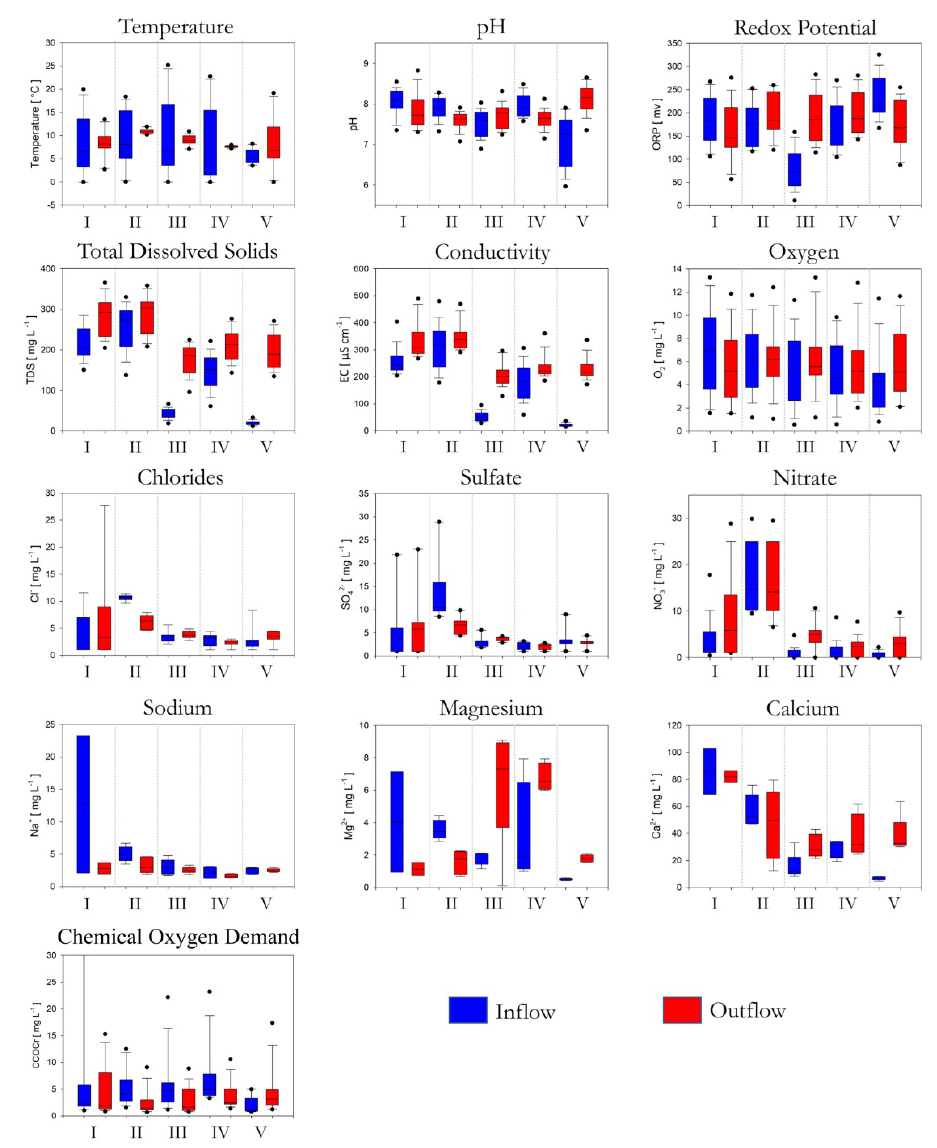
Figure 2. Physico-chemical parameters across the different time points and sampling sites shown as blue and red boxplots for the ponors and springs, respectively. Lines show the median, the boxes and whiskers show the 25th and 75th and 10th and 90th percentile, respectively. The raw chemistry measurements are provided in Table S4 .